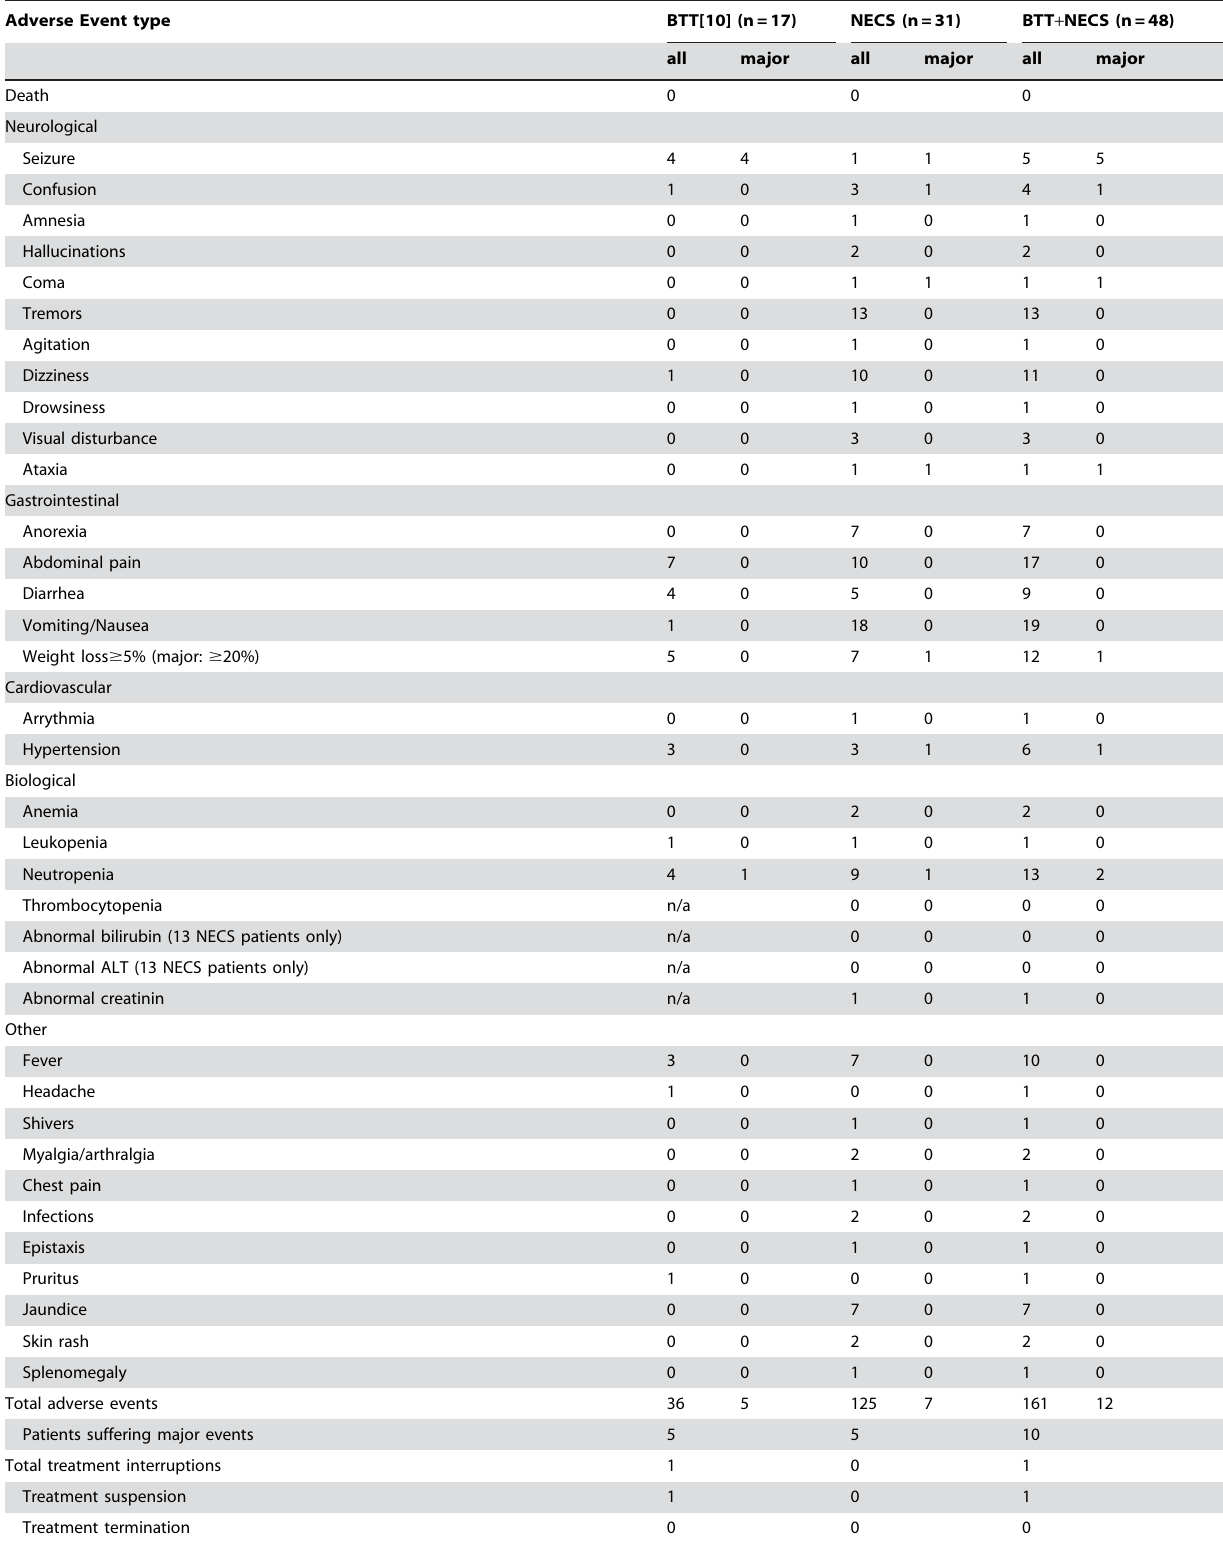
Table 3. Adverse events during